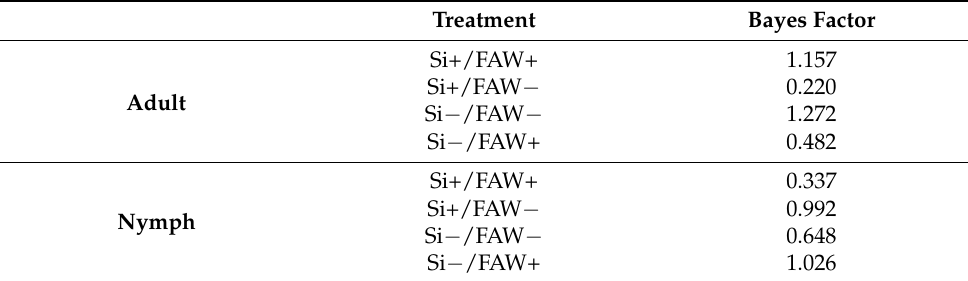
Table 2. Bayes factors (BF) associated with the fixed-effect parameters for each treatment. BF < 3 indicates no evidence for a difference from the prior expectation of no treatment effect, and BF < 1 indicates evidence against an